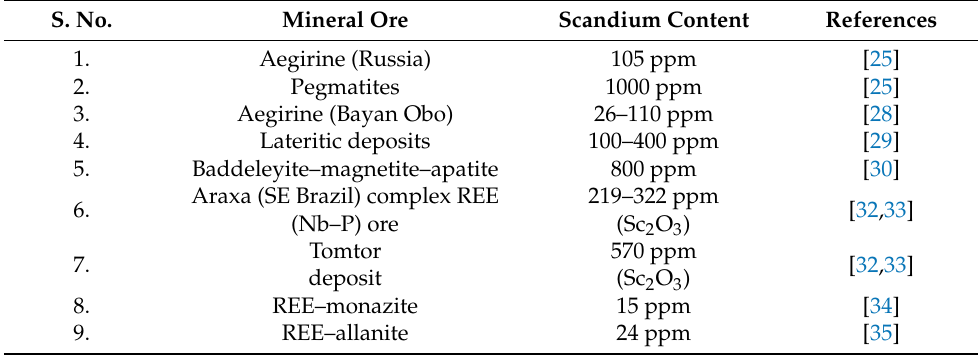
Table 1. Concentration of scandium in different mineral ores other than bauxite ores.